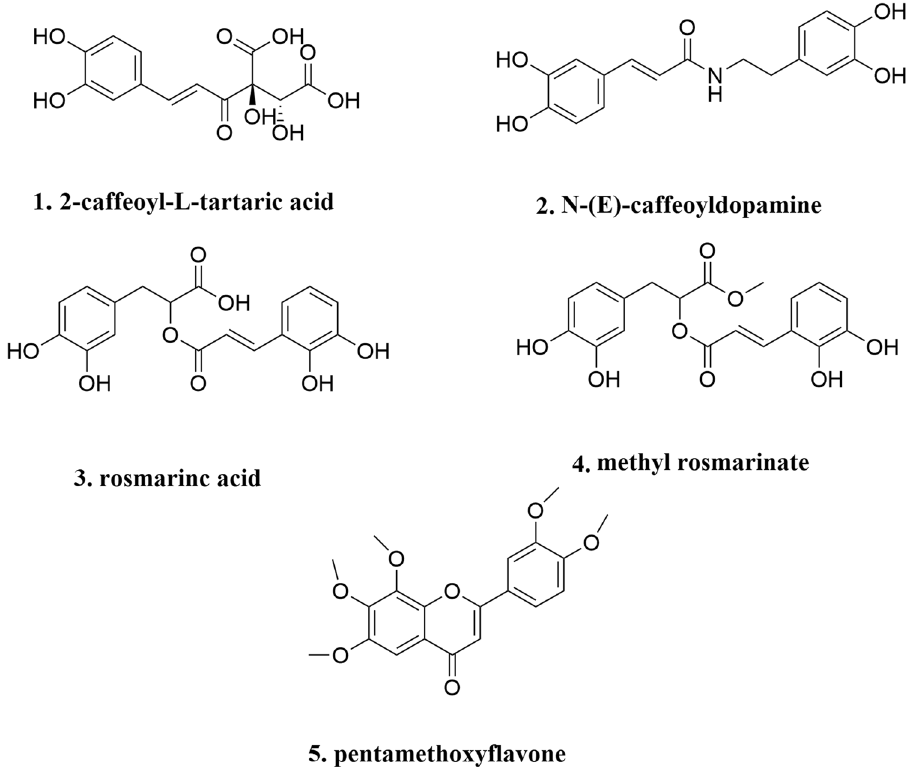
Figure 5. The chemical structures of the five compounds.